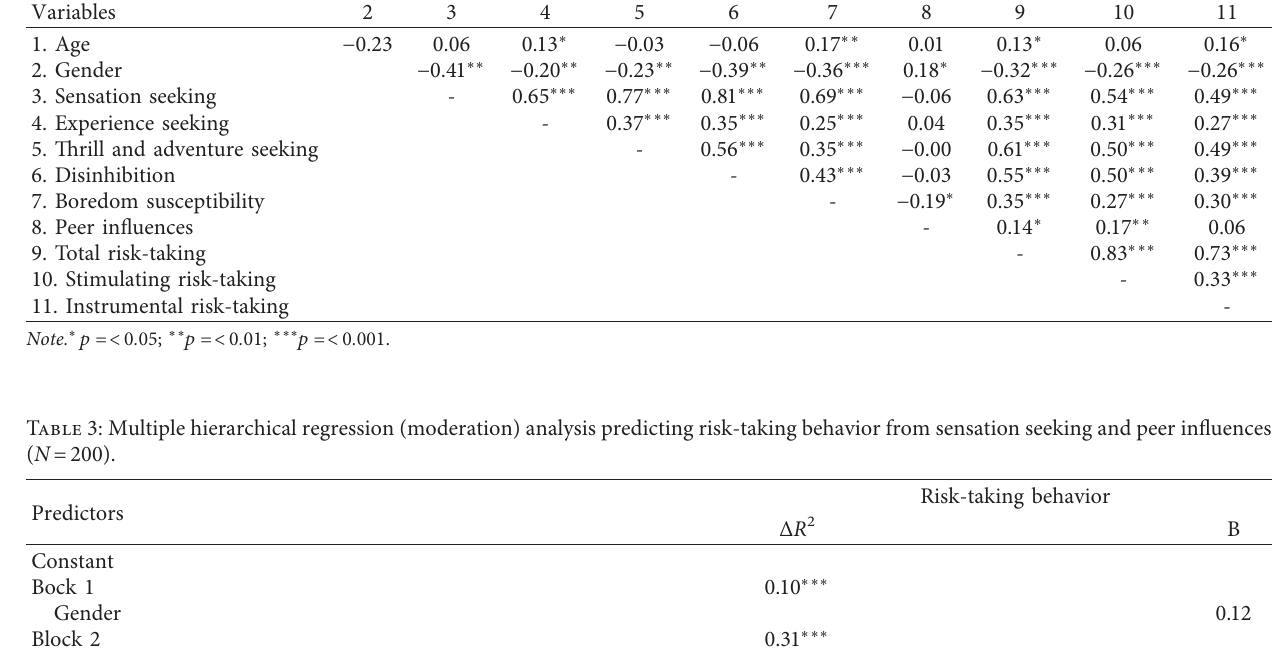
Table 2: Pearson product moment correlation between sensation seeking, peer influences, and risk-taking behavior in adolescents ( N � 200). Variables